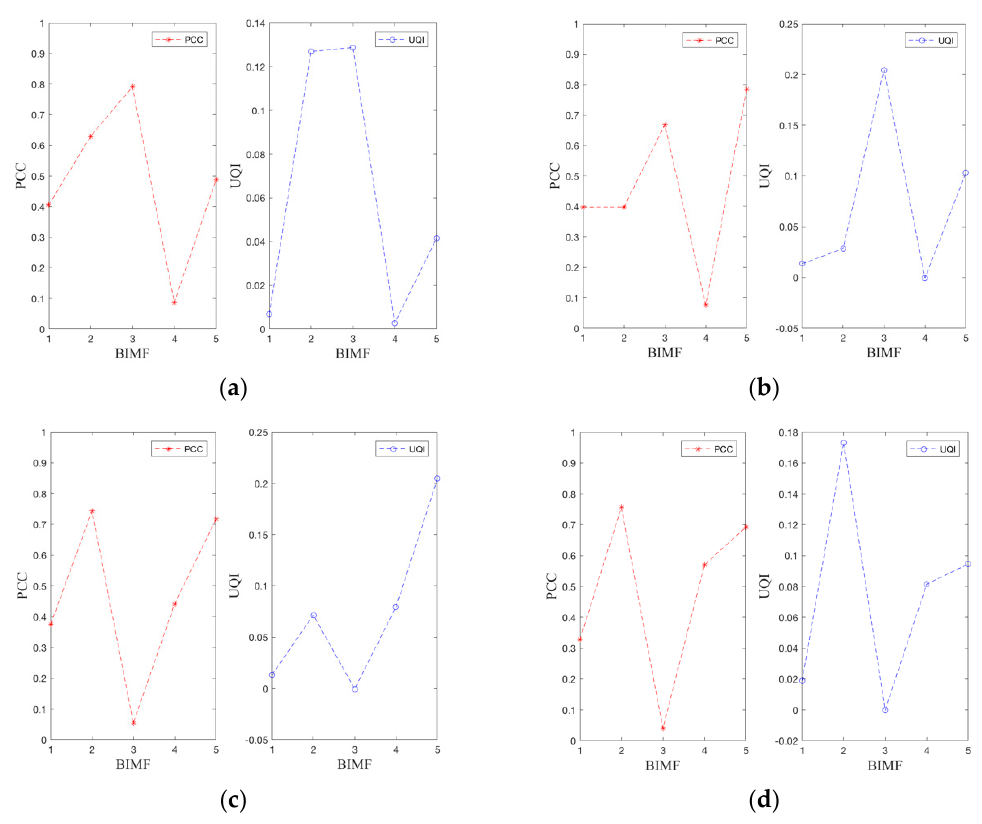
Figure 7. PCC and UQI indicators for feature extraction of human motion 2D echo analysis signals of UWB radar. ( a ) The PCC and UQI indicators for feature extraction of walk forward of human motion 2D echo analysis signal. ( b ) The PCC and UQI indicators for feature extraction of fall forward of human motion 2D echo analysis signal. ( c ) The PCC and UQI indicators for feature extraction of walk around of human motion 2D echo analysis signal. ( d ) The PCC and UQI indicators for feature extraction of jump forward of human motion 2D echo analysis signal.